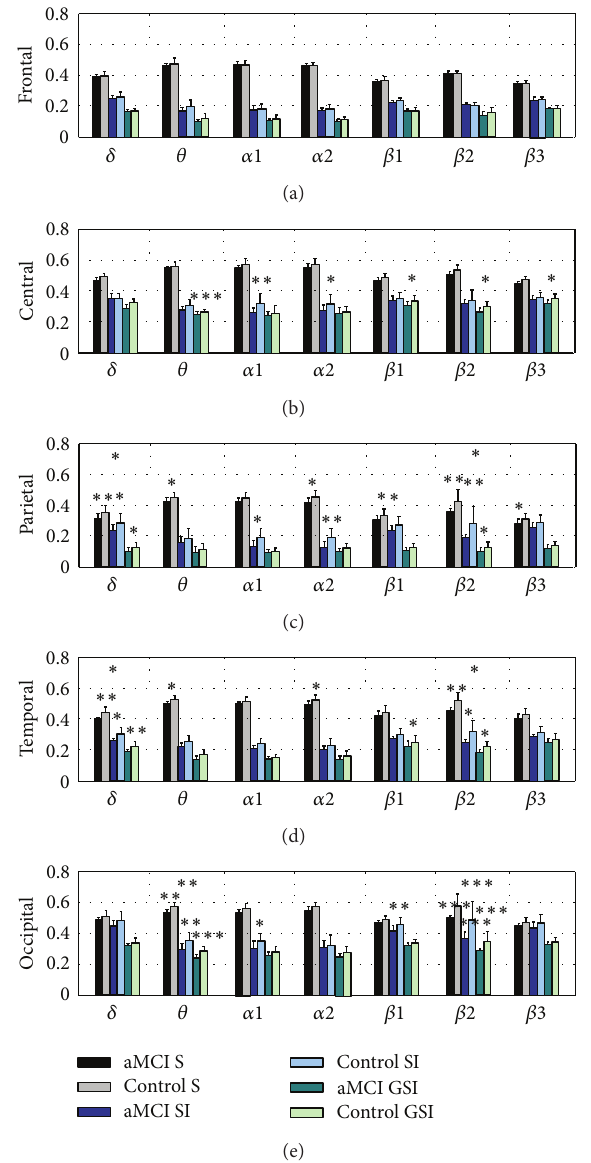
Figure 1: Regional synchronization values (mean ± standard error) of delta, theta, alpha1, alpha2, beta1, beta2, and beta3 bands which were calculated by the 𝑆 -estimator, SI, and GSI method in aMCI and control group. Post hoc analysis results were graphically displayed inside the horizontal bar over the graph: asterisks were referred to aMCI/control comparison: one asterisk means 𝑃 < 0.05 , two mean 𝑃 < 0.01 , and three mean 𝑃 < 0.001